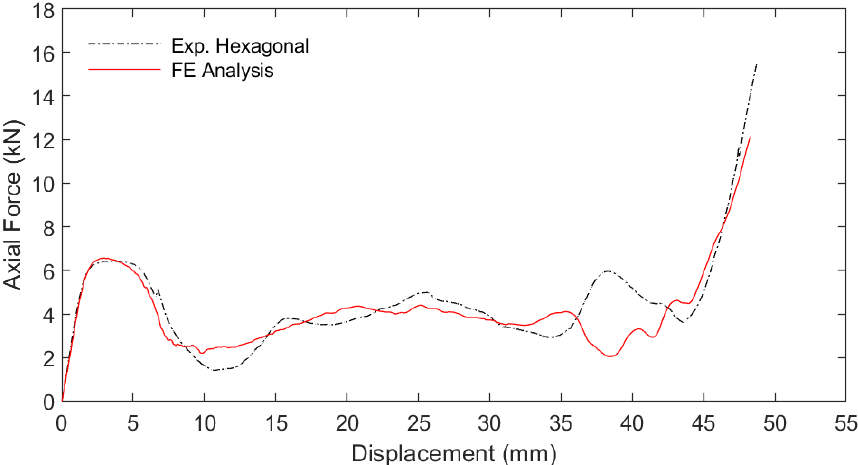
Figure 19. Load vs. displacement curves for hexagonal cell under axial load: comparison between experimental and FEA.